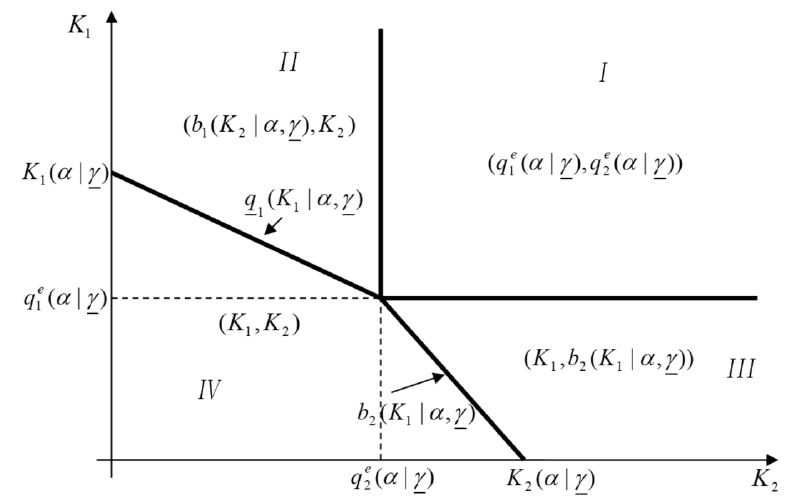
Figure 2. Subgame Equilibrium Production under Capacity Constraint, α ≥ β